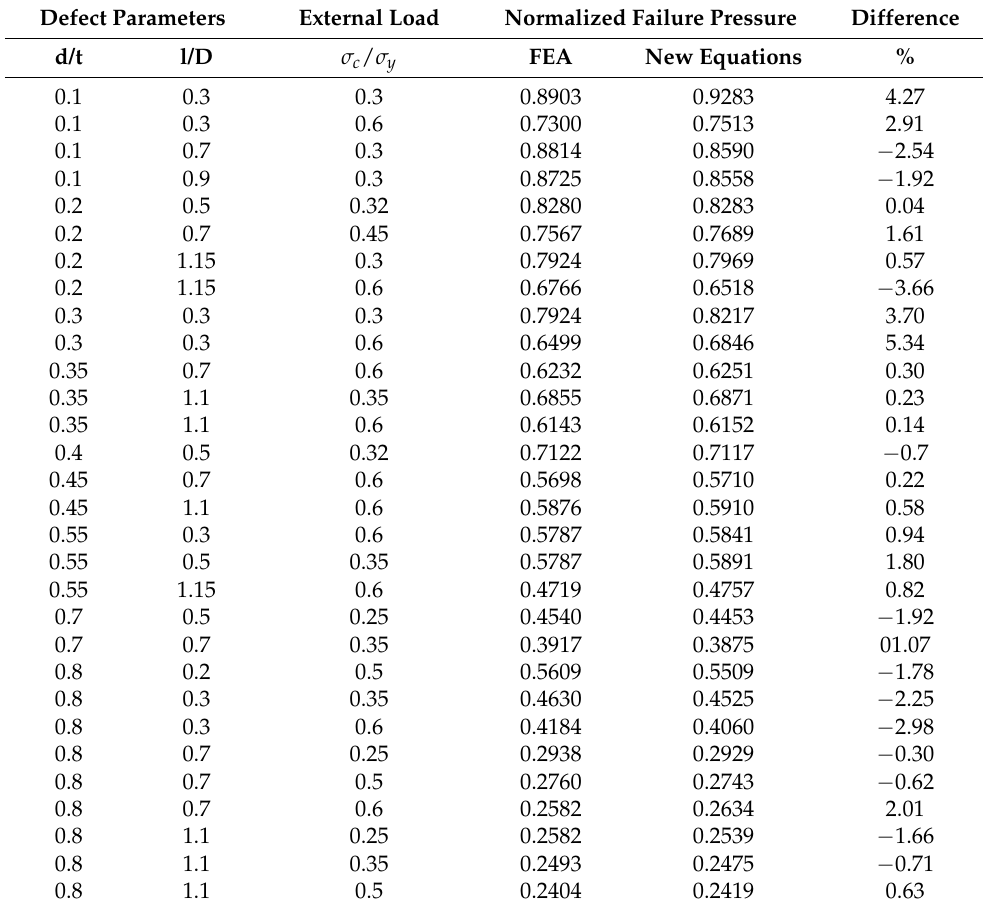
Table 11. Normalized failure pressure prediction using FEA and prediction made by new assessment equations on unseen